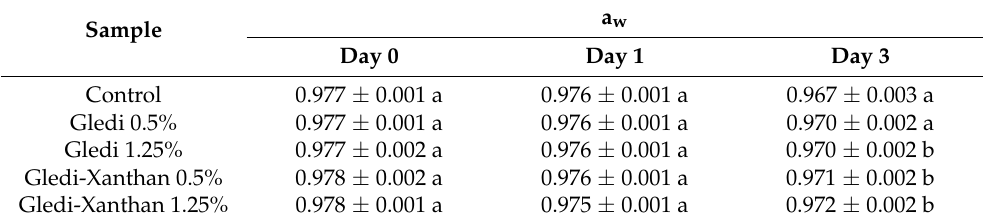
Table 6. Crumb water activity.